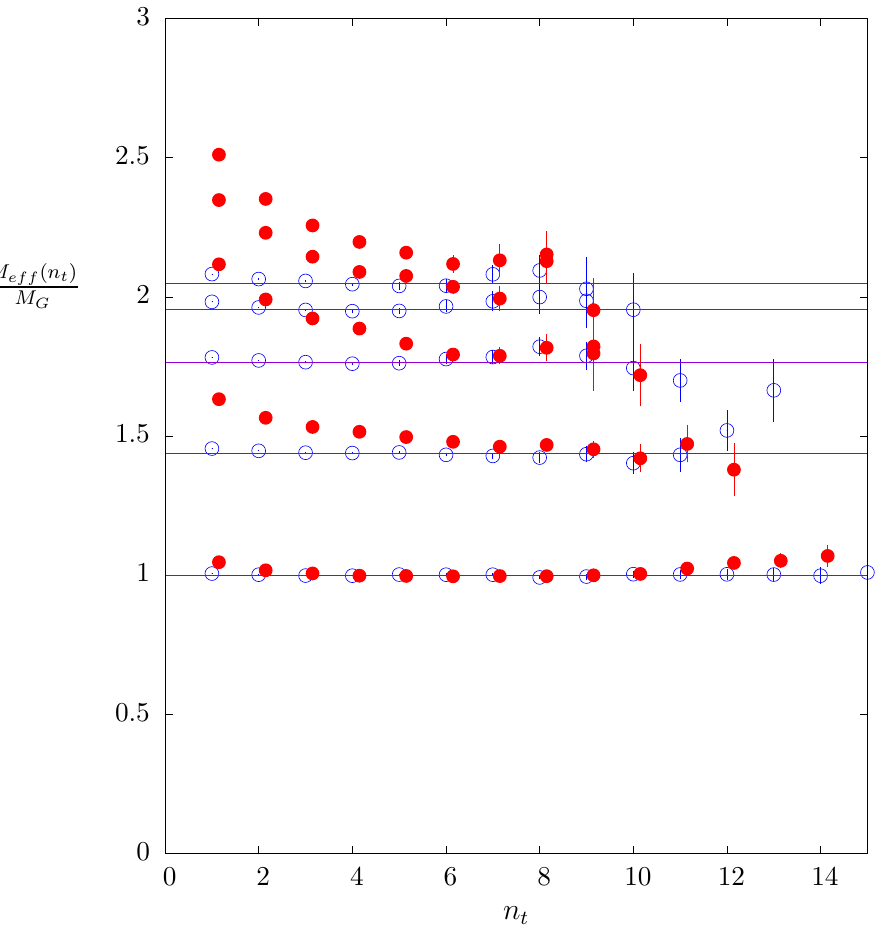
Figure 6 . E(cid:11)ective masses of the lightest (cid:12)ve scalar glueballs in SO(3) ( (cid:15) ) at (cid:12) = 11 on a 100 2 80 lattice and in SU(2) ( (cid:14) ) at (cid:12) = 26 : 5 on a 104 2 80 lattice, in units of their respective mass gaps. Lines are SU(2) mass